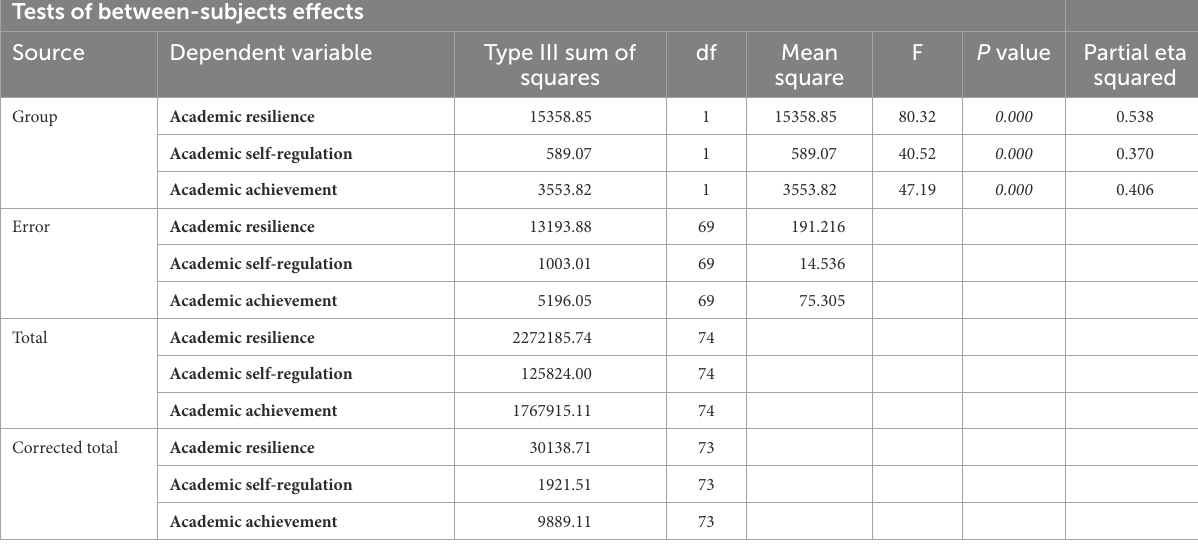
TABLE 5 Comparison of the values of research